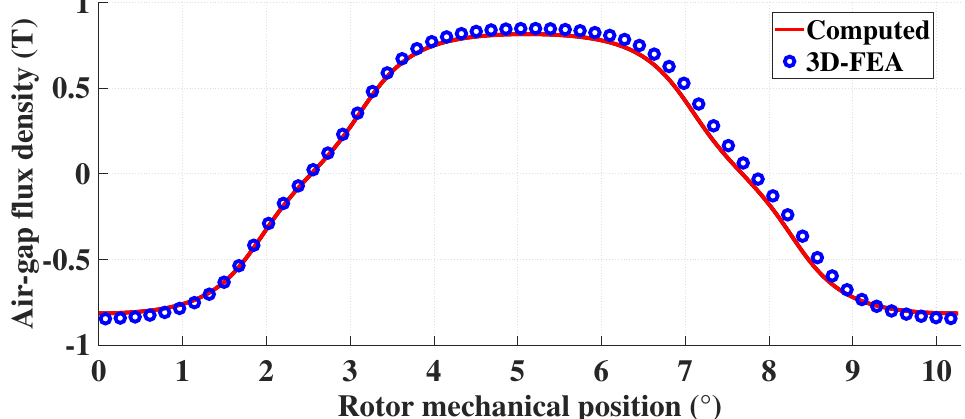
Figure 15. Computed and 3D-FEA air-gap axial flux density as a function of rotor mechanical position. The back-EMF variation as a function of rotor angle is shown in Figure 16. The back EMF calculated with the model used for the design is in very good agreement with the 3D- FEM computation. Furthermore, both axial flux density and back EMF have a sinusoidal profile and a low level of harmonic content (THD = 3.1%) as shown in Figure 17. This leads to a low motor torque ripple value, as illustrated in Figure 18.